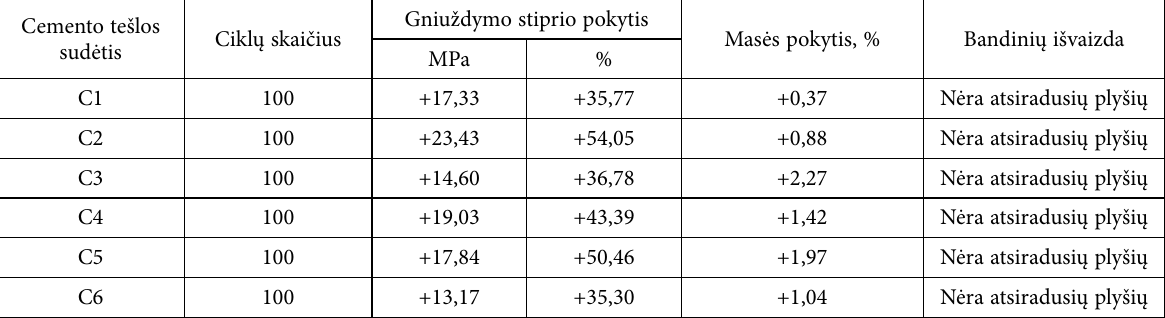
Masės pokytis, % Bandinių išvaizda